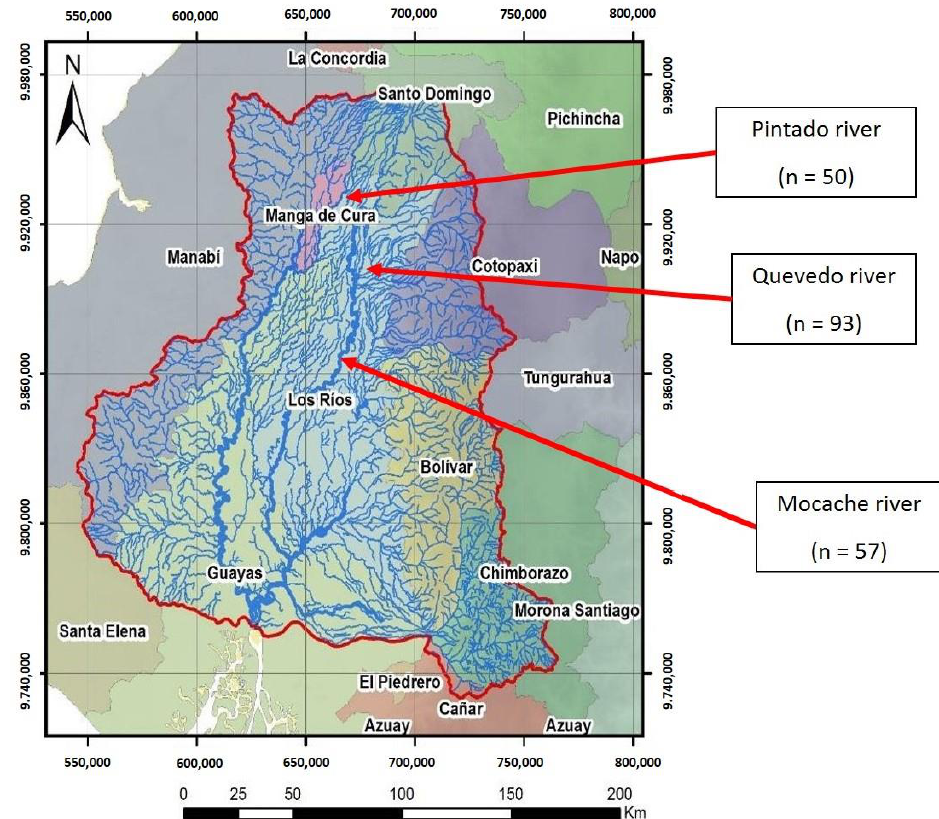
Figure 1. Guayas hydrographic basin (CHG). Site 1: Pintado river; Site 2: Quevedo river; Site 3: Mocache river (n = sample size).